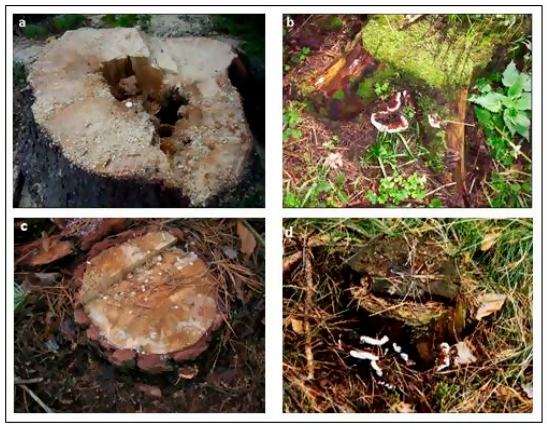
Figure 2. Wood decay (left) and sporocarps (right) in Norway spruce stumps infected with H. parviporum (upper ( a , b) ) and Scots pine stumps infected with H. annosum (lower ( c , d )).